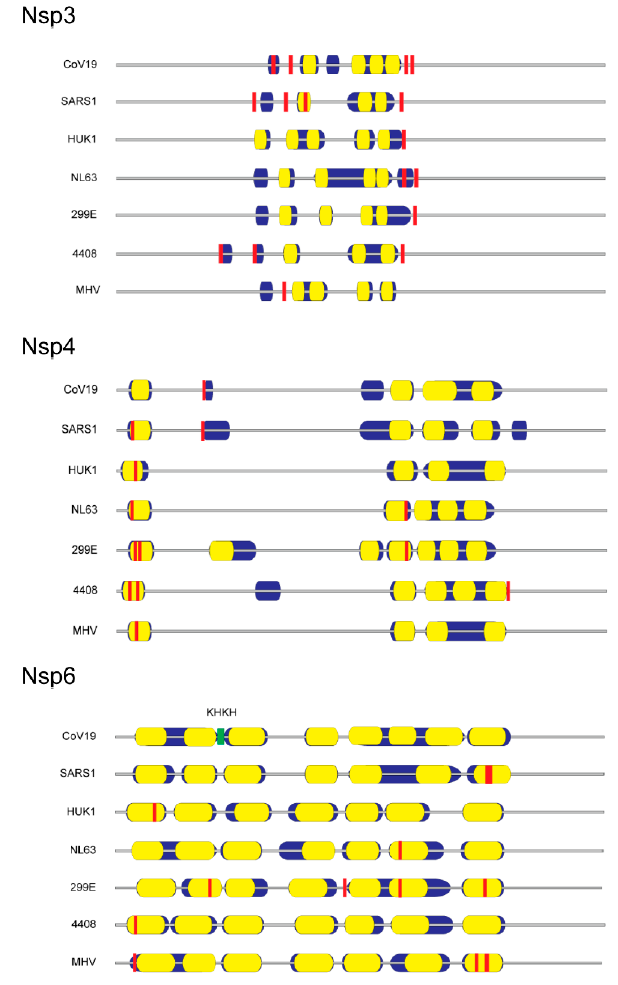
Figure 2. Distribution of potential membrane-associated palmitoylated cysteine residues in coronavirus nonstructural proteins 3, 4 and 6. Diagrams show relative amino acid length with predicted hydrophobic domains (blue), internal transmembrane sequences (yellow), and consensus sites of cysteine palmitoylation (red). Coronavirus nonstructural protein sequences were obtained from GenBank accession IDs listed in Figure 1.